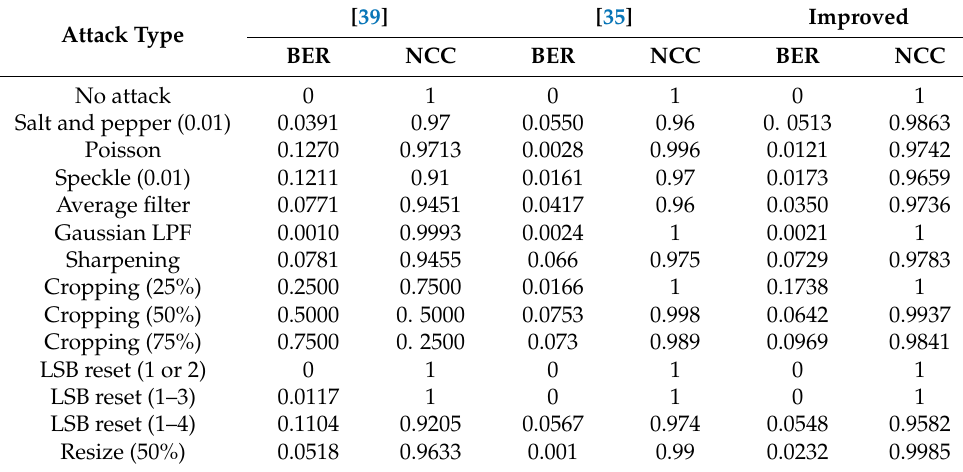
Table 4. Comparison of the improved scheme with the original scheme [35] and scheme [39] in multiple attack modes.